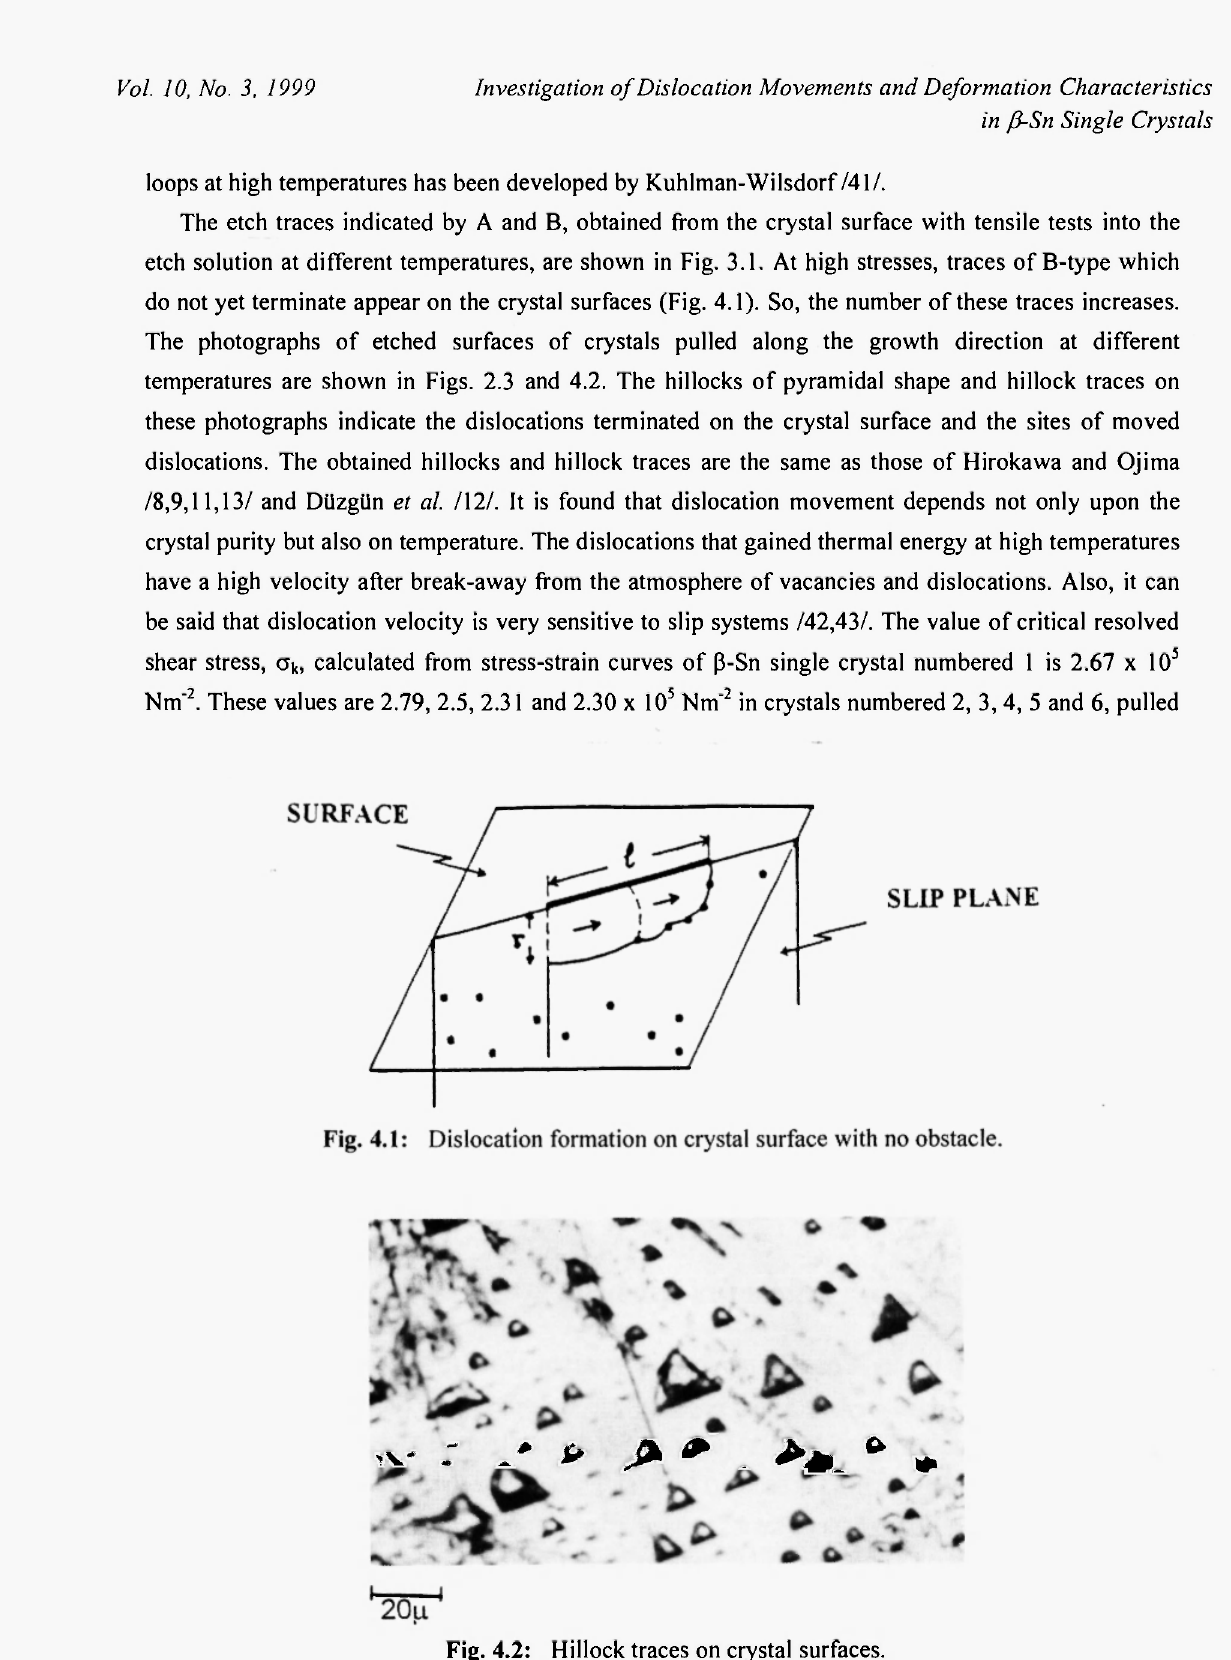
Fig. 4.2: Hillock traces on crystal